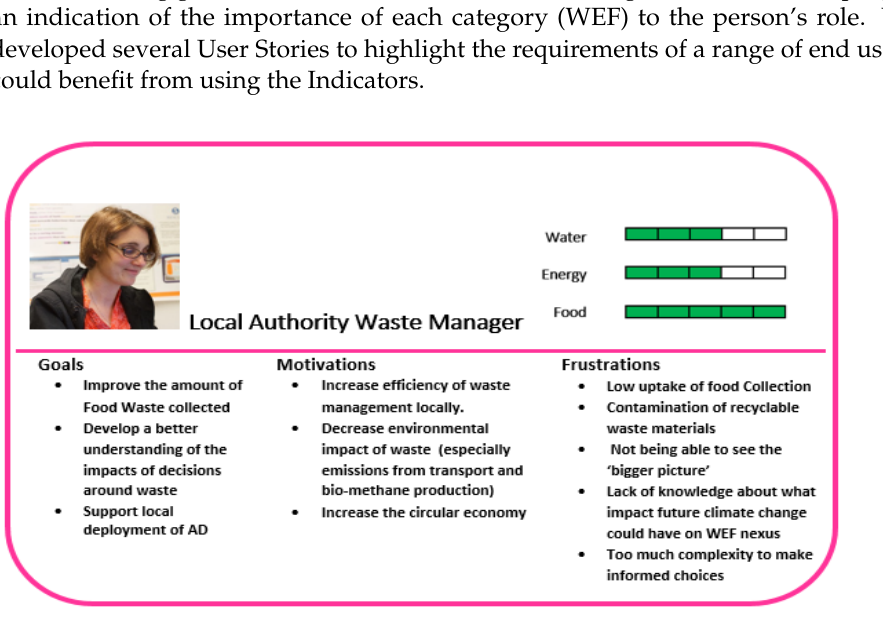
Table 1. The three possible future scenarios considered. Share & Connect Create & Cope Big & Smart Decentralised digital society A highly centralised society A society troubled by climate with high levels of connection where big infrastructure change, but with vibrant between producers, supplies for basic needs, innovation in services systems consumers and the regulated for transparency catering for most needs. environment. and efficiency.